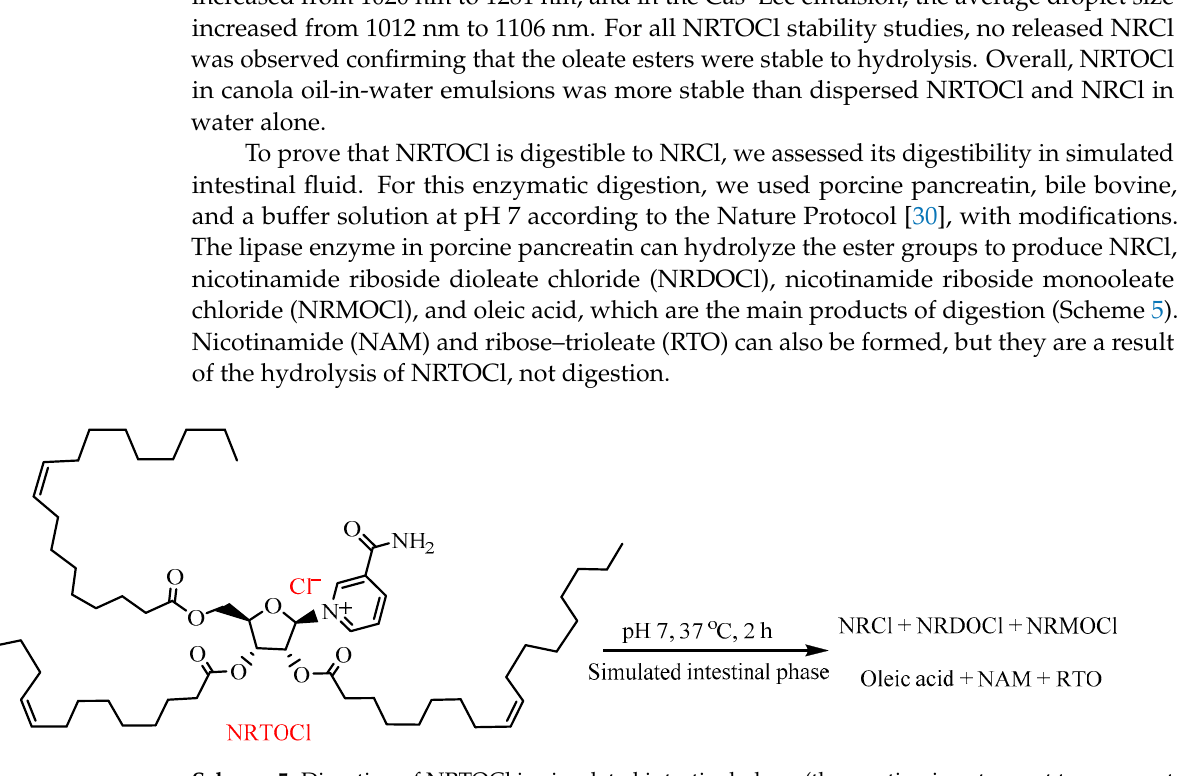
Scheme 5. Digestion of NRTOCl in simulated intestinal phase (the reaction is not meant to represent a stoichiometric